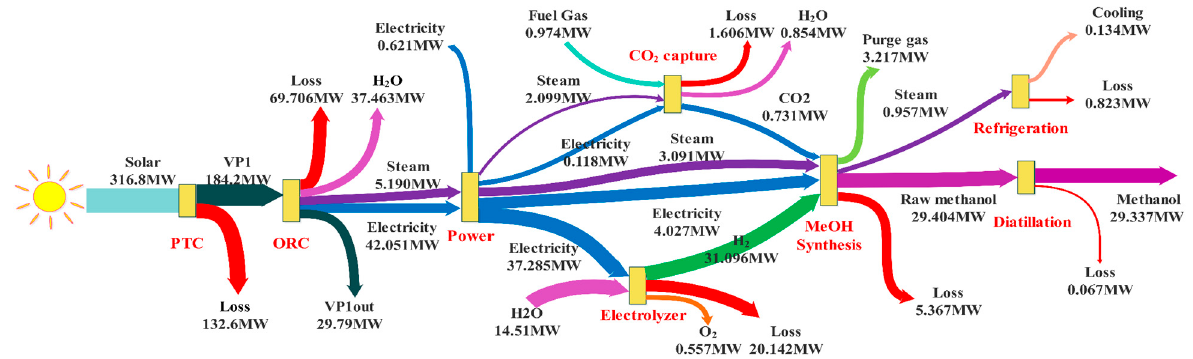
Figure 5. Energy efficiency of the proposed process, CTM, GH-CTM process.